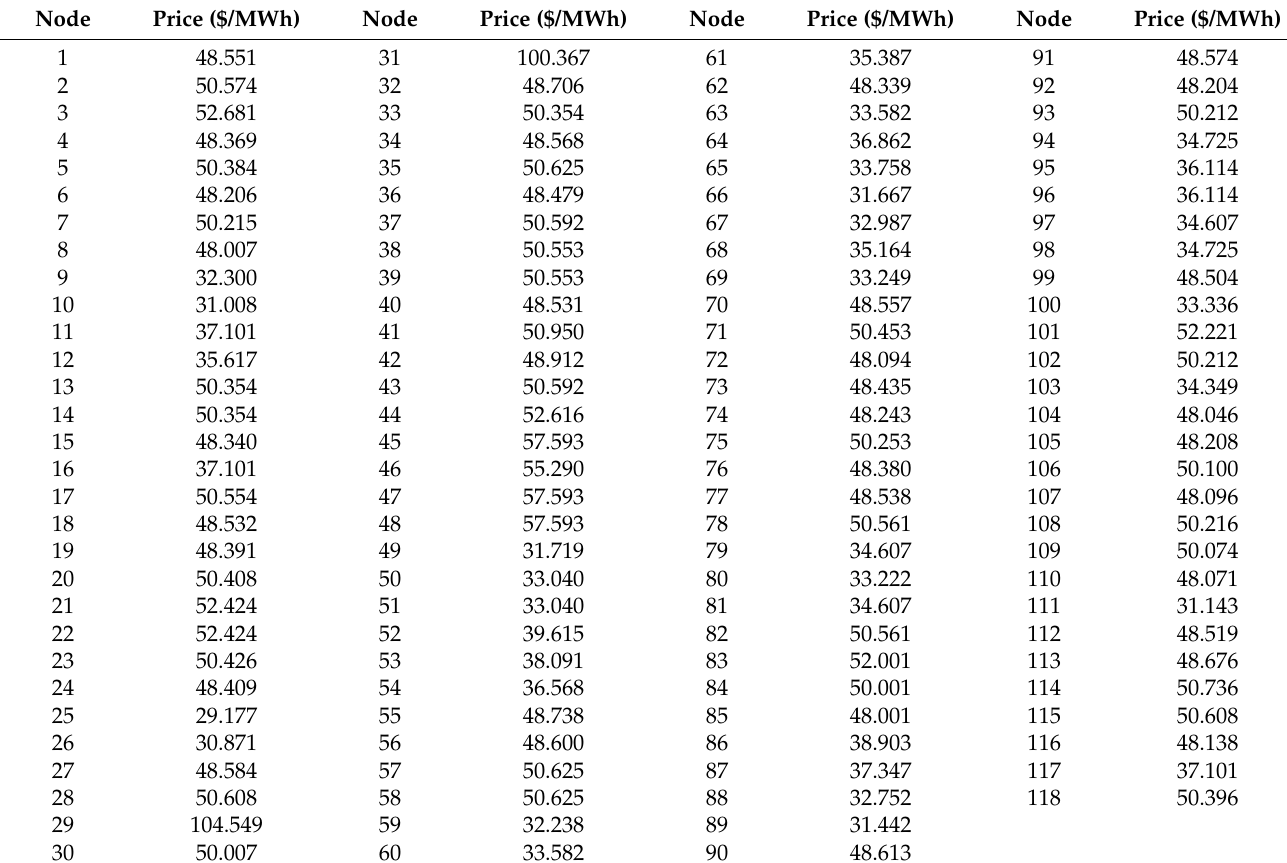
Table A2. Nodal prices of the IEEE 118-node